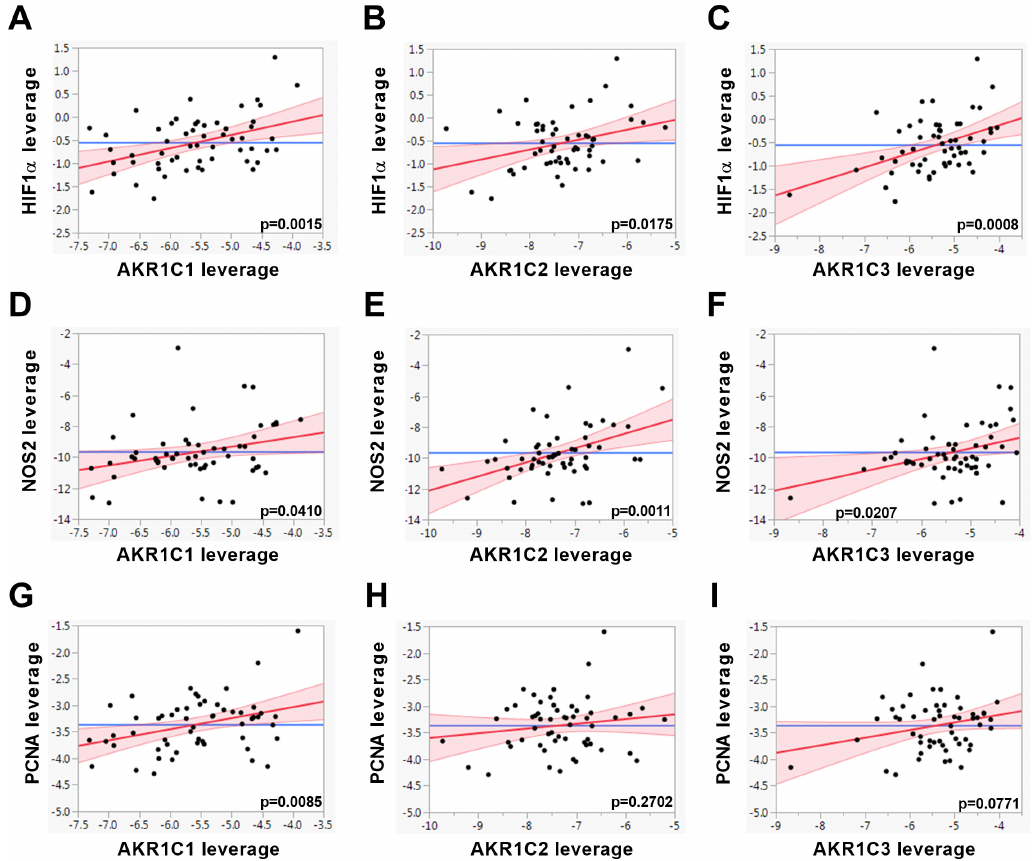
Figure 2. The gene expression levels of AKR1C1, AKR1C2, and AKR1C3 were associated with the genes indicated using multiple linear regression models adjusted for age and BMI in benign (BEN) prostate and prostate cancer (PCa) tissues of PCa patients with and without T2D ( n = 56) and are shown as leverage plots. Statistical significance was considered as p < 0.05. The p -values are indicated in the figures.